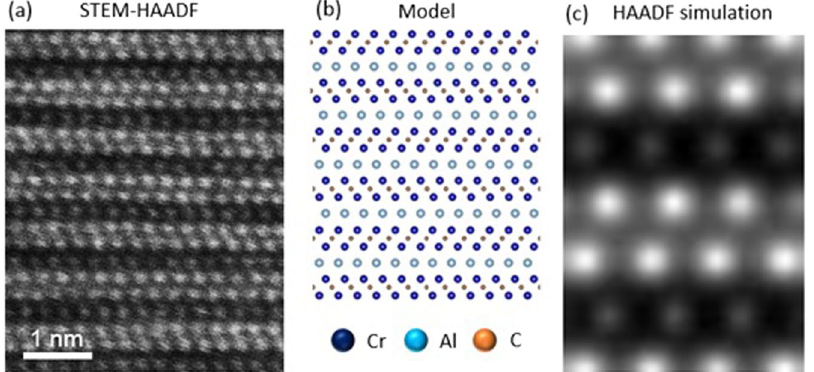
Figure 1. ( a ) Unprocessed STEM-HAADF image in the direction of [1010] shows the Z-contrast distribution of chromium and aluminium atomic columns in the MAX phase structure. ( b ) A model of Cr 2 AlC MAX phase structure, ( c ) Simulation result of STEM-HAADF under consideration of partial temporal and spatial coherence. The probe is assumed to have no